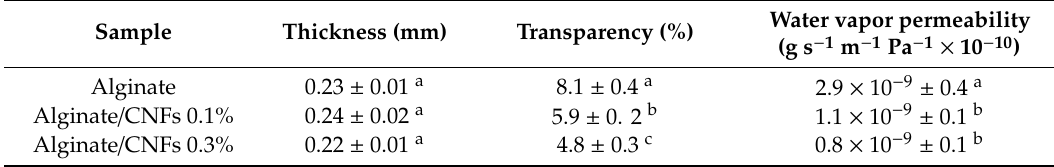
Table 1. Thickness, water vapor permeability, and transparency of the alginate films with and without cellulose nanofibrils from cocoa